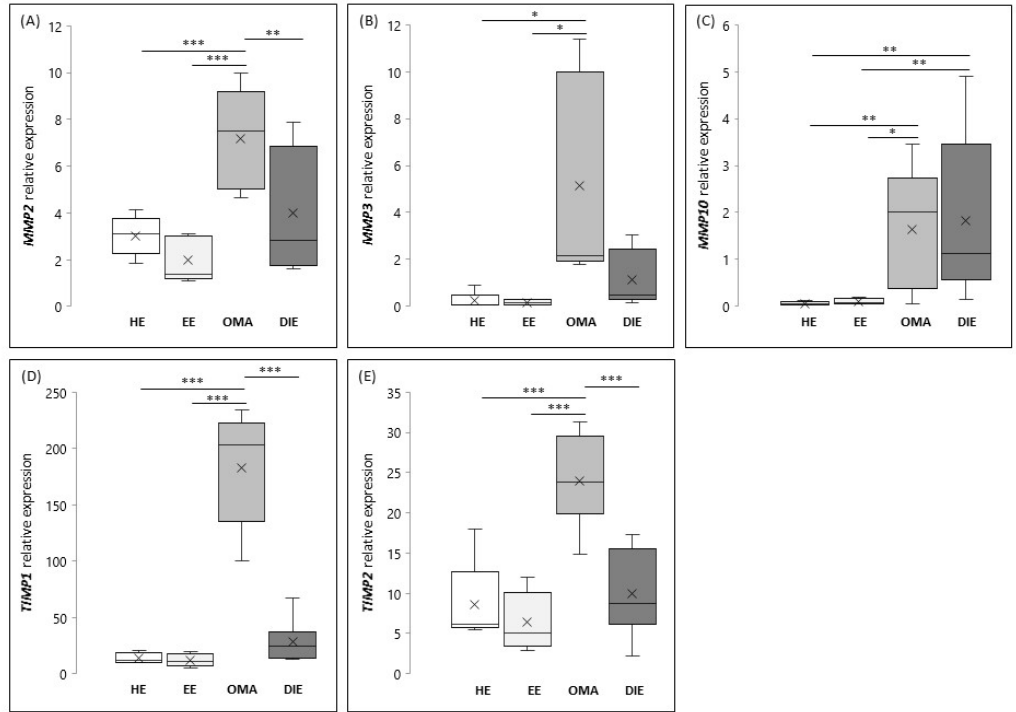
Figure 1. Expression of matrix metalloproteinases (MMPs) and tissue inhibitors of MMP (TIMPs) in human healthy (HE) and eutopic (EE) endometrium, in ovarian endometrioma (OMA) and in deep infiltrating endometriosis (DIE) lesions. MMP2 ( A ), MMP3 ( B ), MMP10 ( C ), TIMP1 ( D ), and TIMP2 ( E ). Graphical diagrams are plotted as box-whisker plots, where boxes show the interquartile range with median and mean values, and whiskers represent min and max confidence intervals. Number of analyzed samples: HE: 15, EE: 19, OMA: 10, DIE: 9. Data represent value obtained by 2 - ∆ Ct method. * p < 0.05; ** p < 0.01; *** p < 0.001.